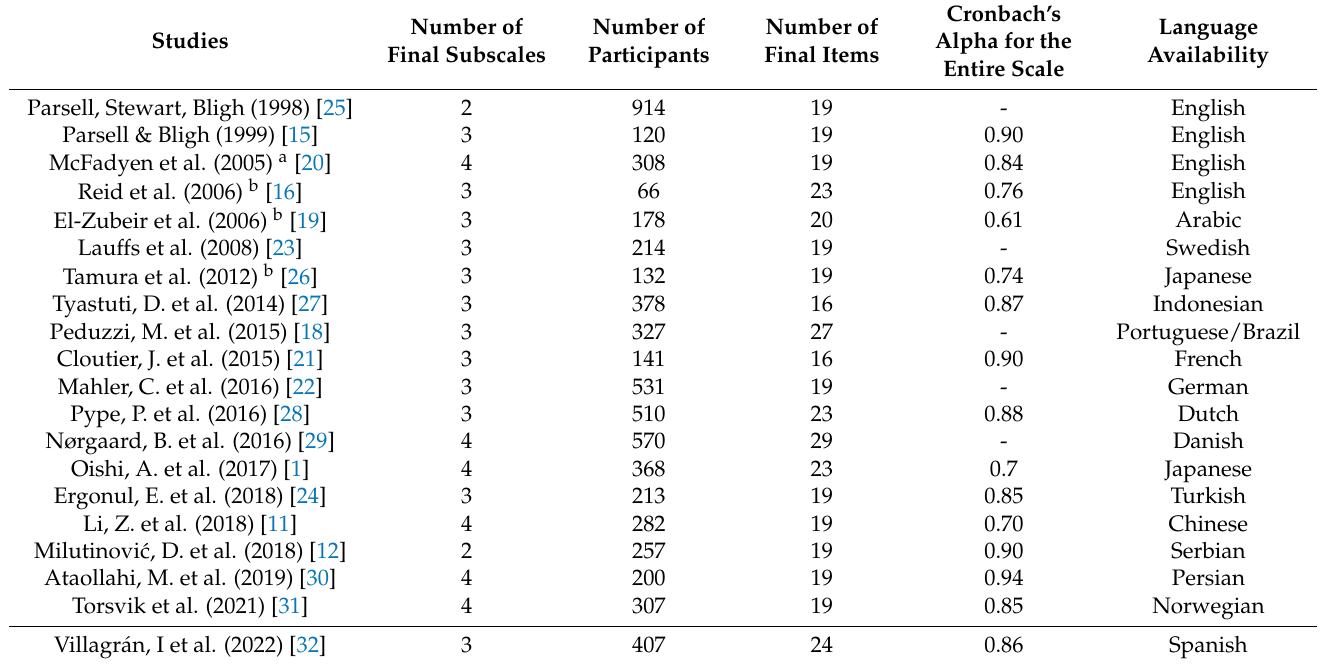
Table 1. RIPLS characteristics and coefficient of reliability from previous